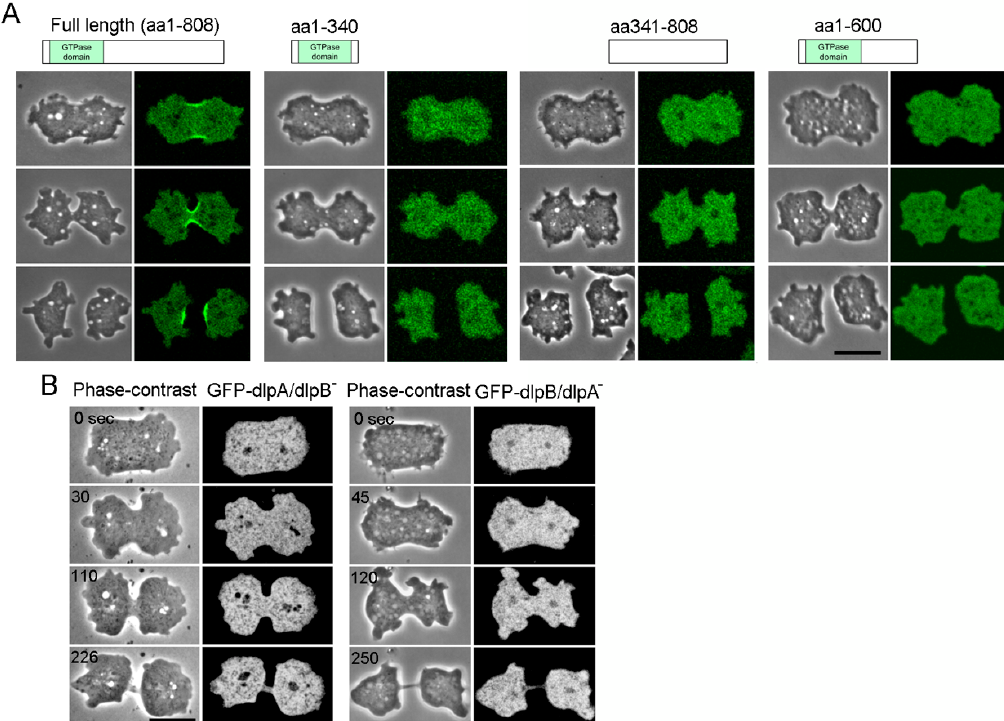
Figure 4. Both dlpA and dlpB are required for their localization to the furrow. ( A ) Domain analysis of dlpB for its localization at the furrow. GFP-fusion proteins with the GTPase domain (aa 1–340), a fragment without the GTPase domain (aa 341–808), and a fragment without the C-terminal domain (aa 1–600) were expressed in dlpB - cells. Typical phase contrast and fluorescence images during cytokinesis. Only full length dlpB localized at the furrow. ( B ) When GFP-full length dlpB was expressed in dlpA - cells, dlpB did not localize at the furrow (right panel). When GFP-full length dlpA was expressed in dlpB - cells, dlpA did not localize at the furrow (left panel). These observations were confirmed in more than 25 cells for each case. Bars, 10 µm.